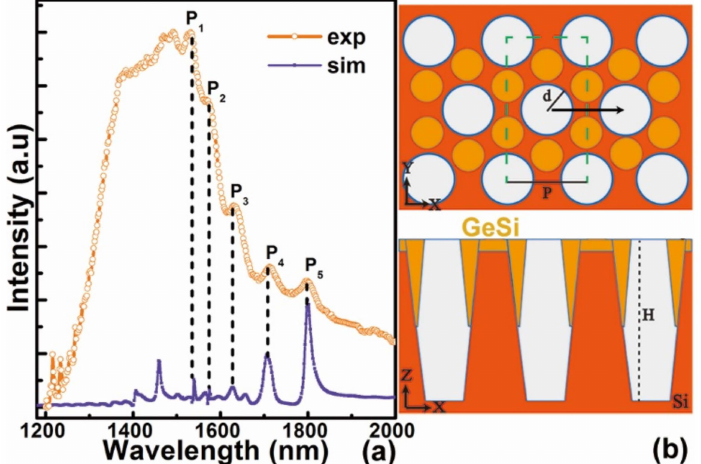
Figure 6. FDTD simulations. ( a ) Simulated spectrum of guided resonant modes of ordered micro- holes after graded Ge x Si 1 − x (x = 0.1–0.3) alloys growth, as well as the experimental PL spectrum, ( b ) schematic illustration of the top view (up-panel) and the cross-sectional (along the black arrow in the up-panel) side-view (down-panel) of ordered micro-holes. The green dashed lines in the up-panel of ( b ) denotes the simulation cell of 1.02 µ m × 1.77 µ m × 11 µ m. The mesh size in the FDTD simulation is 10 nm × 8.6 nm × 5 nm. The depth H of micro-hole is 5.8 µ m. The period P is 1.02 µ